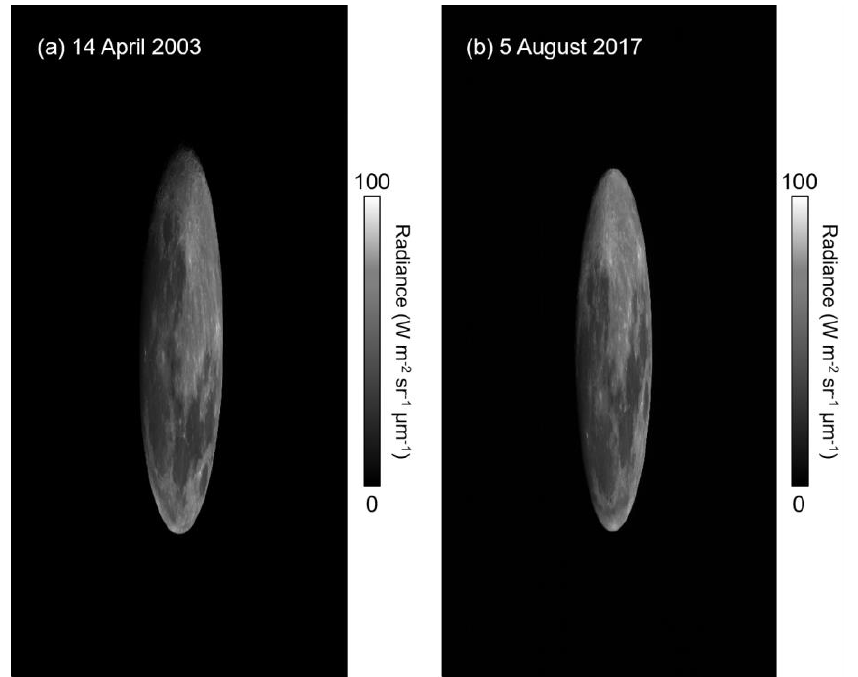
Figure 1. Images of the Moon obtained by ASTER VNIR Band 1 on 14 April 2003 and on 5 August 2017. Because the observation was conducted under oversampling conditions, the Moon’s shape is elongated in the image